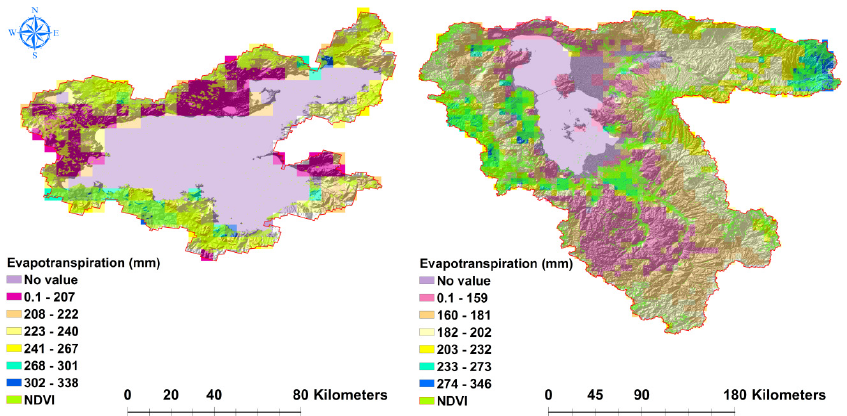
Figure 11. Average long-term ET in the LU and LV basins, which is highly correlated with the NDVI.